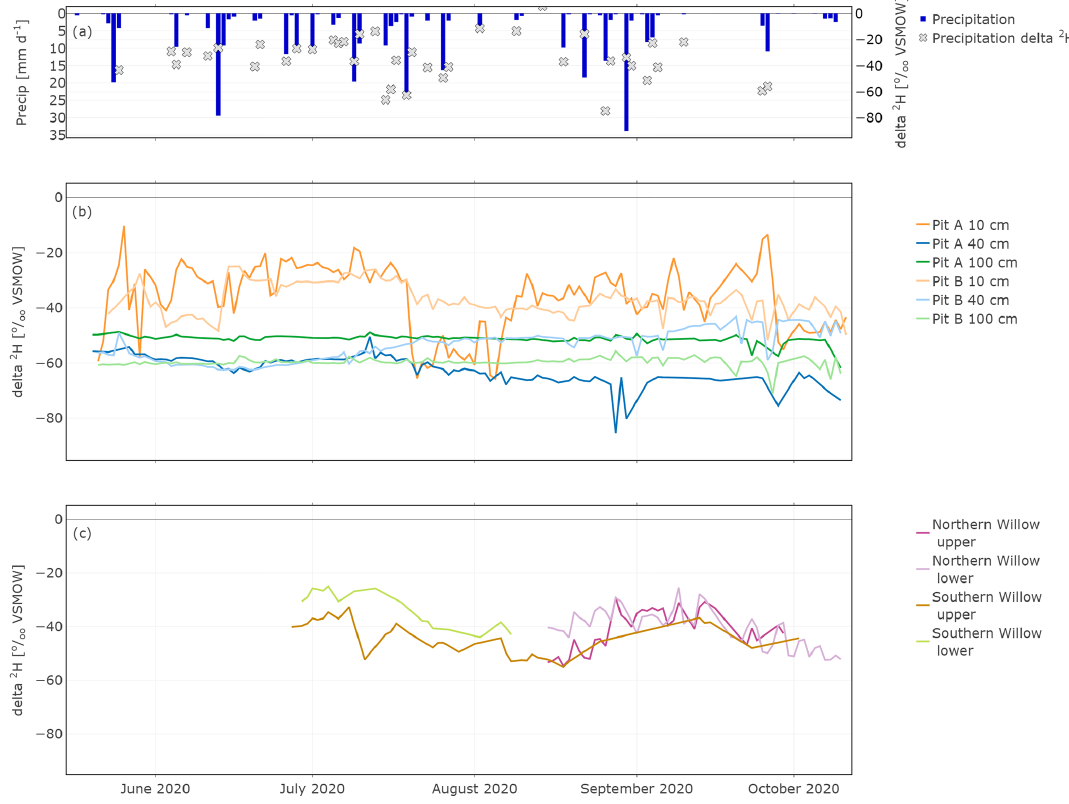
Figure 5. In situ time series of daily δ 2 H in precipitation (a) , Pit A and Pit B (b) , and Northern Willow and Southern Willow (c) . Table 1. The amount (n) and 5th, 50th (median), and 95th percentiles of δ 18 O and δ 2 H (‰ VSMOW) signatures. Results are presented for precipitation, groundwater, surface water (which is lake and stream water combined), in situ soil water at 10, 40, and 100cm combined for both pits (named “Soil 10”, “Soil 40”, and “Soil 100”), bulk soil water at canopy-covered and open space at 10, 40, and 100cm (named “Canopy-covered 10”, “Canopy-covered 40”, “Canopy-covered 100”, “Open space 10”, “Open space 40”, and “Open space 100”), in situ xylem water at the upper and the lower borehole combined for both willows (named “Tree upper” and “Tree lower”), and cryogenic extracted xylem water combined for both willows (named “Tree